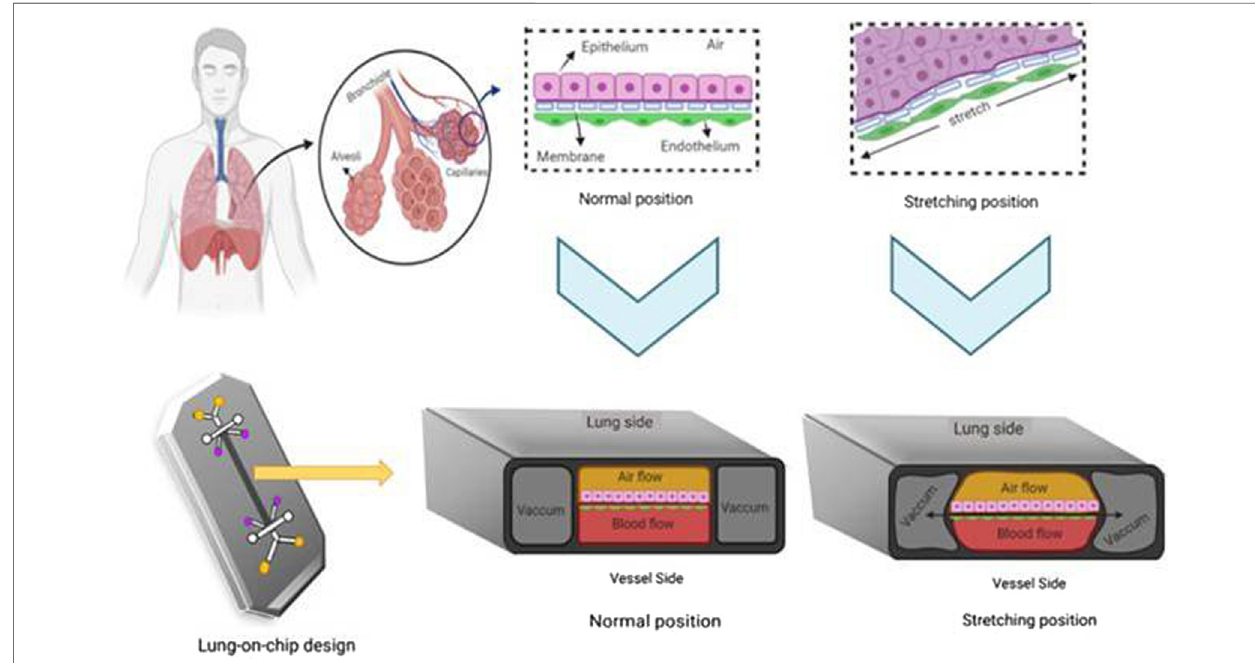
FIGURE 5 | Pictorial representation of the working principle of the organ-on-chip model employed for nanomaterial safety assessment.